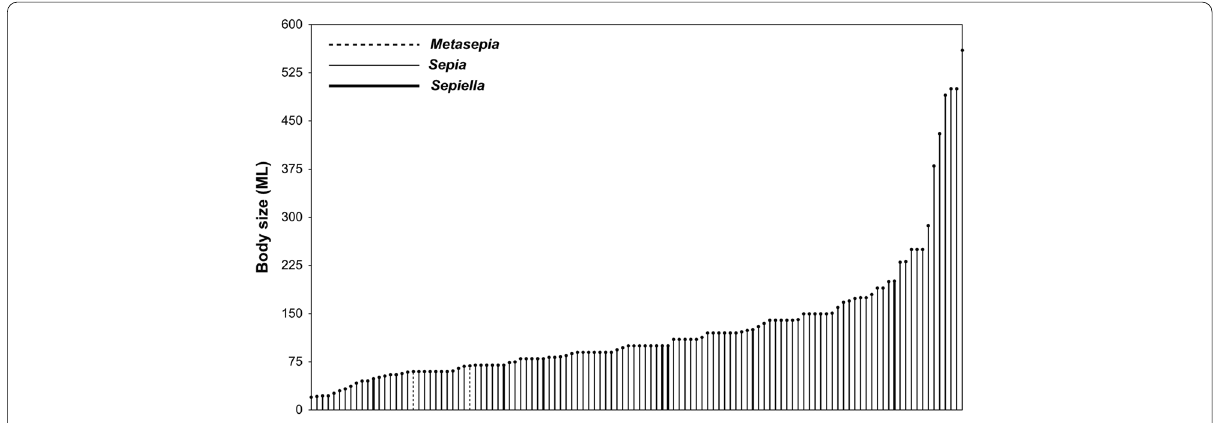
Fig. 3 Body size data (ML) for the 116 sepiid species from smallest to largest. Each vertical bar represents a species